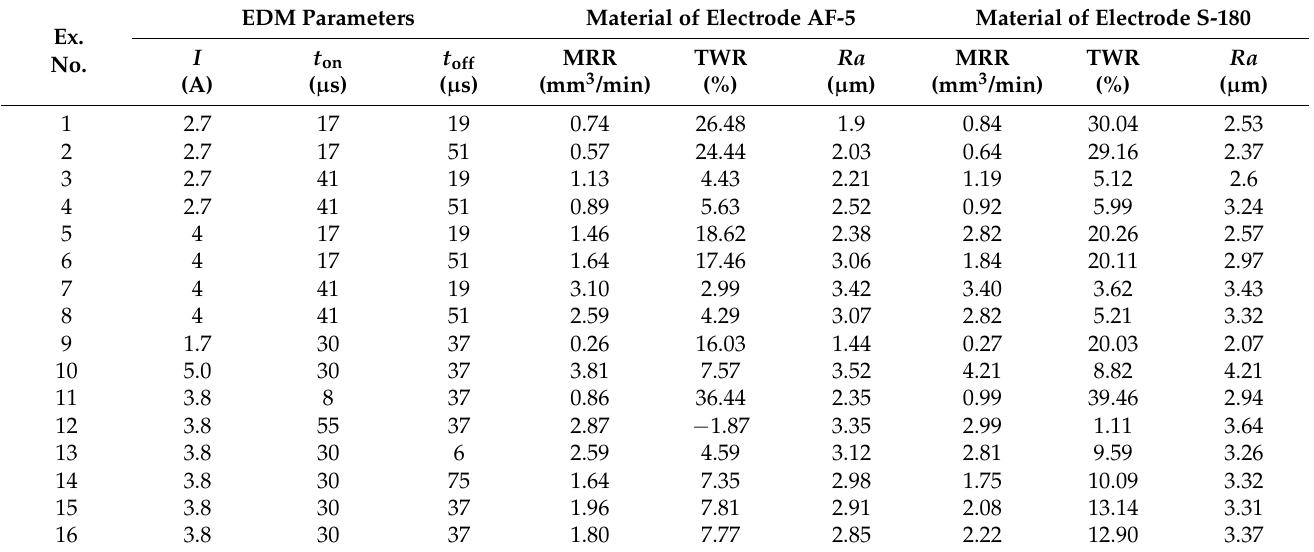
Table 5. The design of the experimental matrix with measurements: material removal rate (MRR), tool wear rate (TWR), and roughness Ra